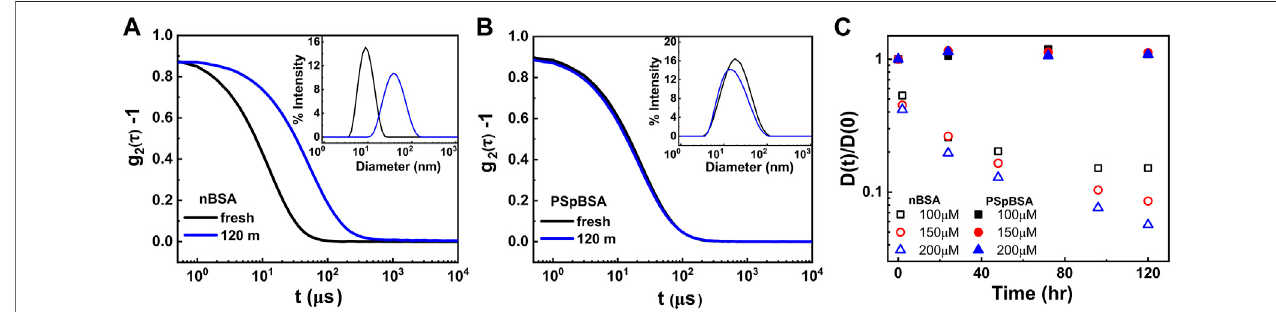
FIGURE 2 | (A,B) Intensity-autocorrelation functions of fresh and heat-set 100 μ M nBSA and 100 μ M PSpBSA solutions, measured using DLS. The insets represent the corresponding intensity distributions as functions of measured particle sizes. (C) Time-evolution of the normalized diffusion coef fi cients of nBSA (open symbols) and PSpBSA ( fi lled symbols) solutions measured at 65 ° C in PBS at pH 7.0, containing 50 mM added NaCl. Here black, red and blue symbols represent the 100, 150 and 200 μ M nBSA and PSpBSA concentrations,